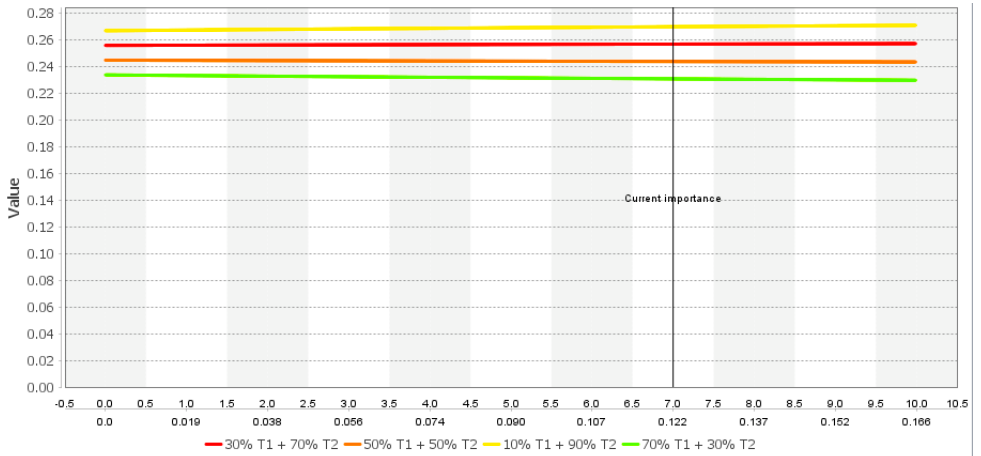
Figure 8. Effects of changing the weighting of the criterion “profitability” on the overall scores of the decision alternatives. The upper values of the x-axis are the absolute weights in the range 0 to 10. The lower values represent the relative normalized weights.